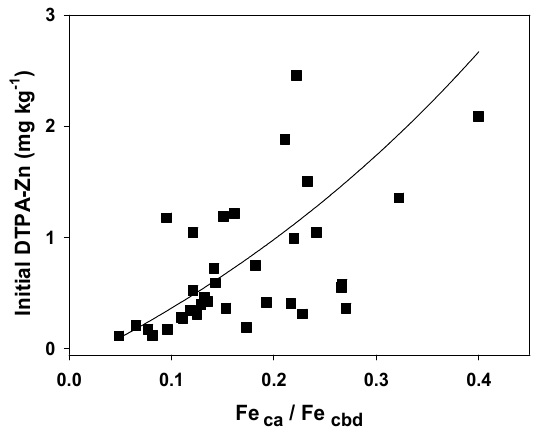
Figure 4. Relationship between the initial DTPA extractable Zn (mg kg –1 ) and the ratio of citrate ascorbate extractable Fe to citrate bicarbonate dithionite extractable Fe (Fe ca /Fe cbd ) in soils. Y = (– 0.53 + 0.43/X) –1 ; R 2 = 0.58; p < 0.0001. Regression for transformed variables to meet normality criteria is Ln Y = 1.76 + 1.27 Ln X; R 2 = 0.45; p < 0.0001.